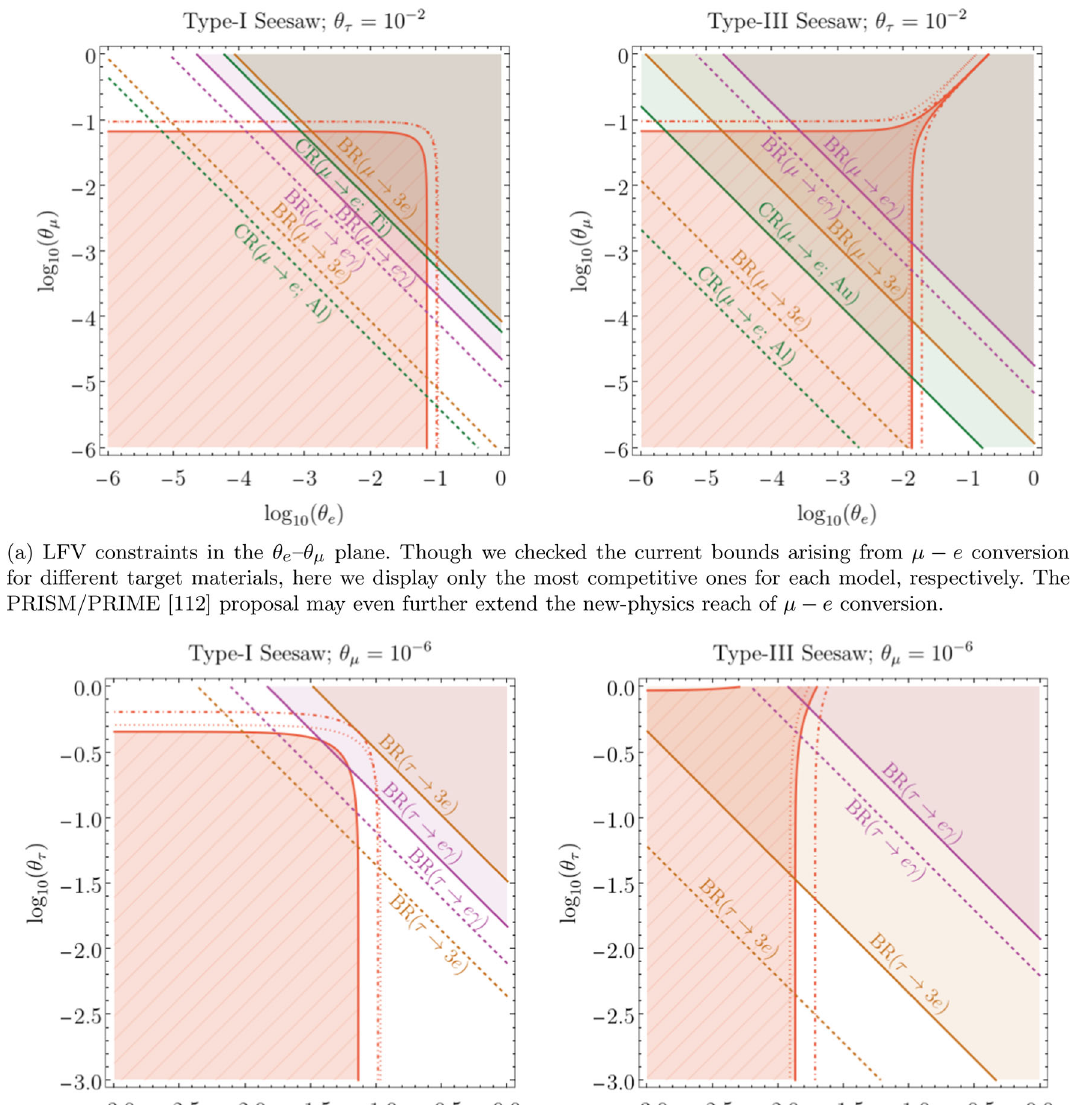
Fig. 5 Current constraints from LFV observables depicted at 90% C.L., together with their prospective future reaches, in comparison with projected sensitivities of precision Higgsstrahlung measurements. The red-ruled regions indicate | (cid:8)σ/σ | < 0 . 5% at dot-dashed and dotted red lines are the corresponding 1% contours